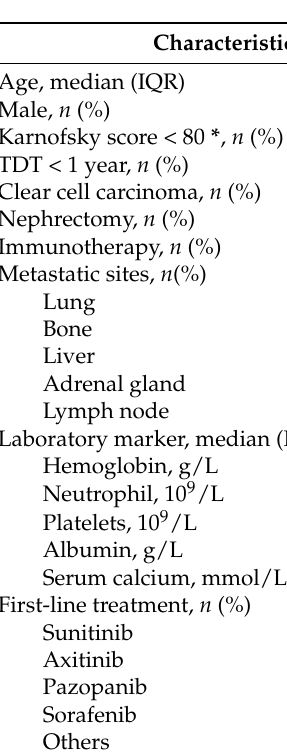
Table 1. Baseline